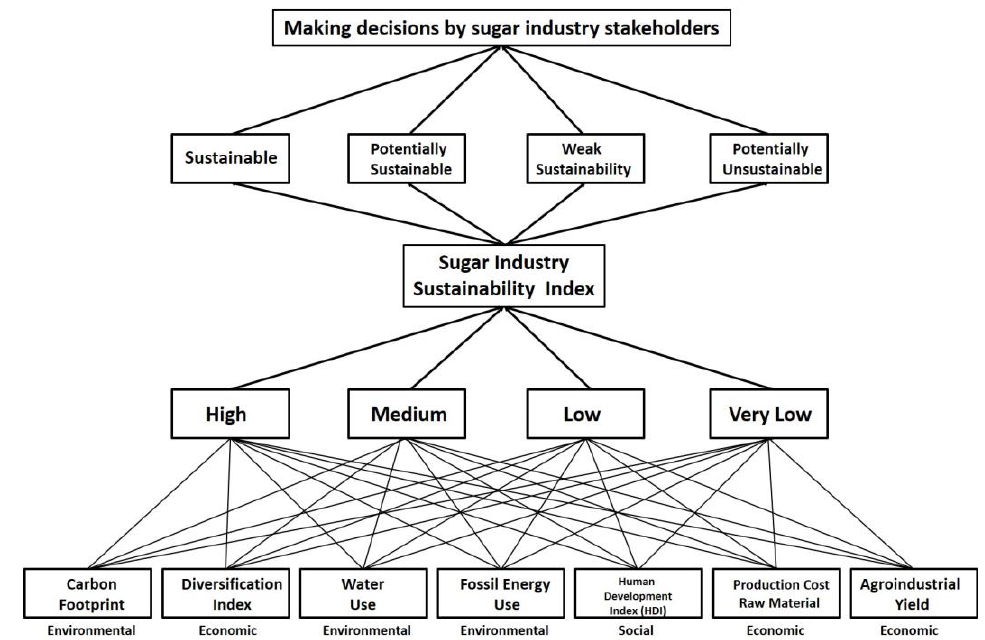
Fig. 6. Sustainability index framework